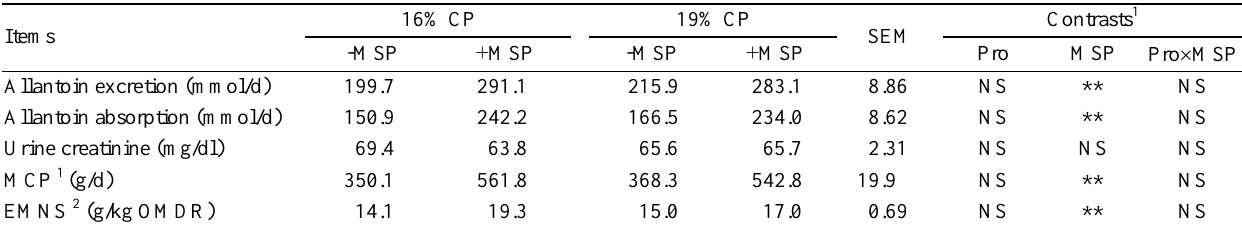
Table 6. Effect of protein level and mangosteen peel pellets (Mago-pel) in concentrate diet on excretion of urinary derivatives and microbial nitrogen supply in lactating dairy crossbreds 16% CP 19% CP Contrasts 1 Items SEM -MSP -MSP Allantoin excretion (mmol/d) 199.7 Allantoin absorption (mmol/d) 150.9 Urine creatinine (mg/dl) 69.4 MCP 1 (g/d) 350.1 EMNS 2 (g/kg OMDR) 14.1 NS SEM = Standard error of the means, NS = Not significant, ** p<0.01. 1 Microbial crude protein (MCP) (g/d) = 3.99  0.856  mmol of purine derivatives excreted (Galo et al., 2003). 2 Efficiency of microbial nitrogen supply (EMNS), g/kg of OM digested in the rumen (OMDR) = ((MCP (g/d)  1,000)/DOMR(g)), assuming that rumen digestion = 65% of digestion in total tract.